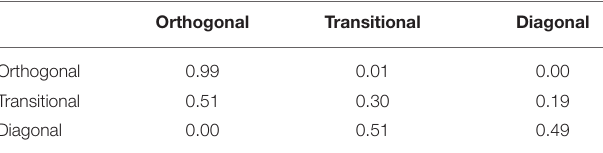
TABLE 1 | Population-level estimated posterior transition matrix across geometric